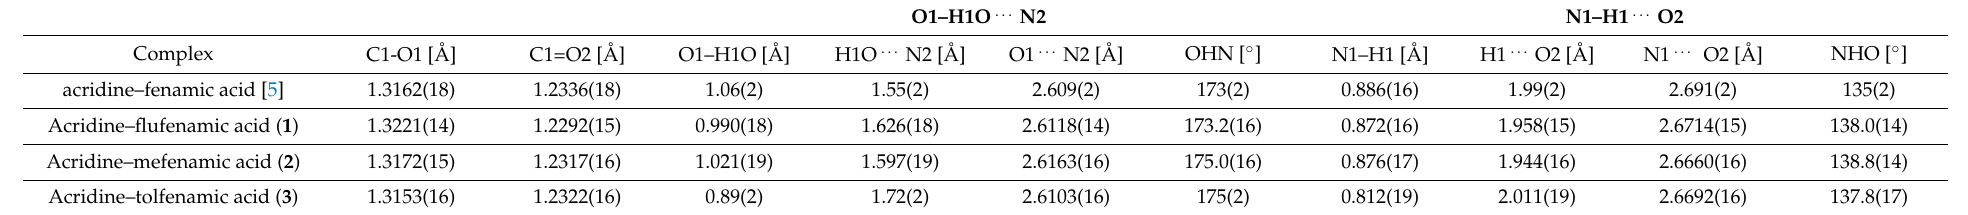
Table 2. Selected geometrical parameters of the investigated complexes of fenamic acids with acridine including inter- and intramolecular hydrogen